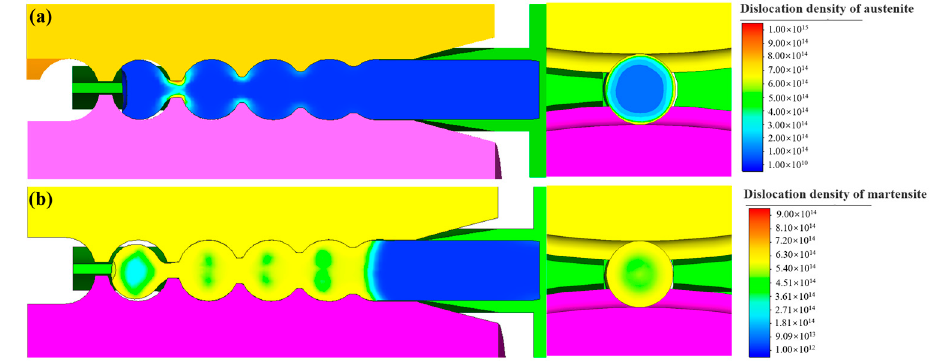
Figure 9. The dislocation density contour of steel balls ( a ) in austenite and ( b ) in martensite.